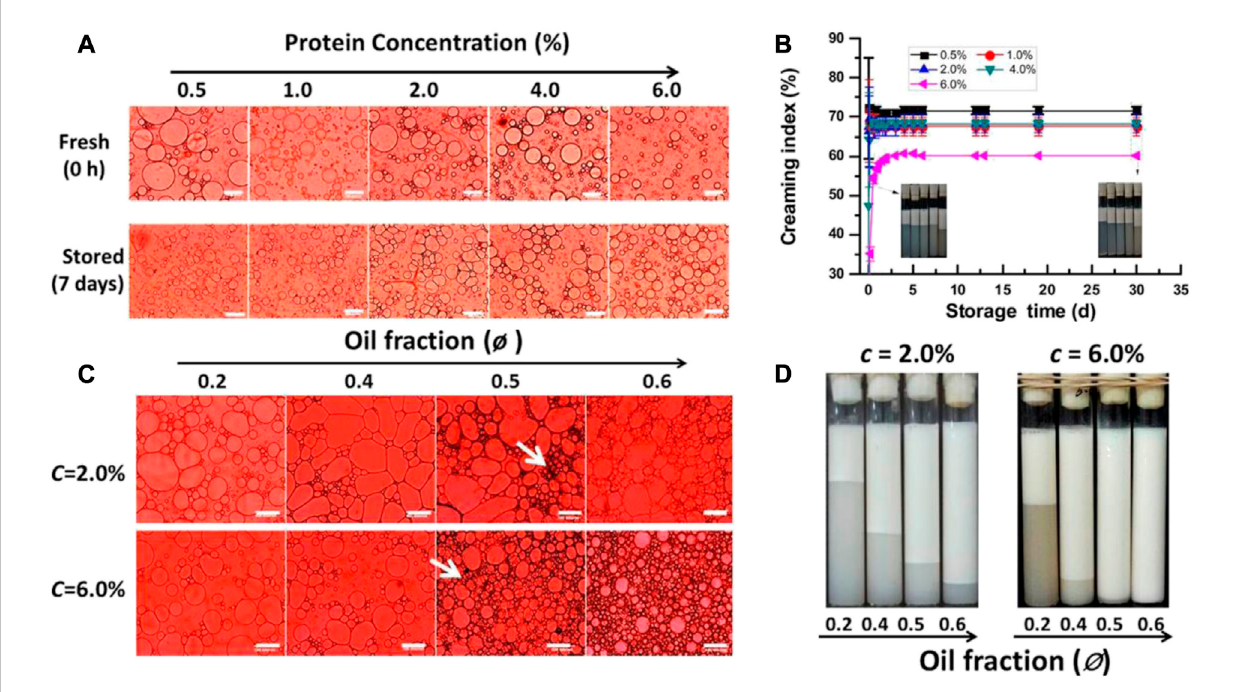
FIGURE 4 (A) Micrographs of emulsions droplets stabilized using soy protein nanoparticles obtained using dispersion of different concentration as were obtained and after aging for 1 week. The scale bars in the micrographs are 100 μ m in length. (B) Evolution of the creaming index for emulsions prepared with a fi xed particle concentration and different volume fractions of oil phase. (C) Micrographs of emulsions droplets stabilized using two different concentrations of soy protein nanoparticles and different oil volume fractions. The scale bars in the micrographs are 100 μ m in length, and the arrows indicate fl occulated oil droplets. (D) Aspects of emulsions stabilized using two different concentrations of soy protein nanoparticles and different oil volume fractions after 1 day of aging. Reprinted from Liu and Tang (2013), with permission from the American chemical society, copyright